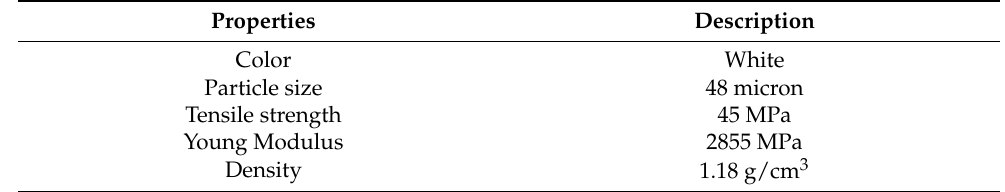
Table 1. Physical and mechanical properties of PMMA.